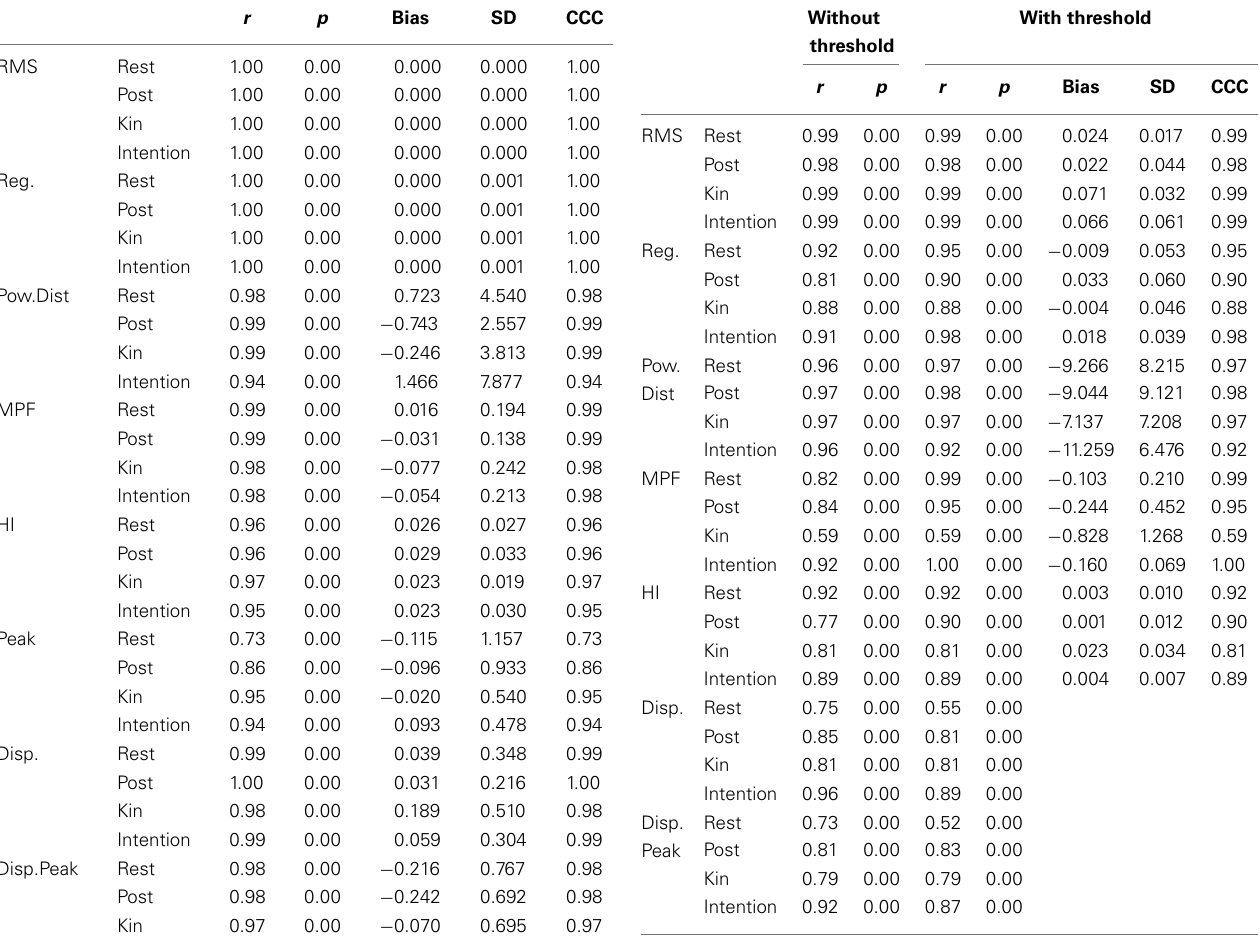
Correlation coefficients are shown for every task performed. Correlation coef- ficients were obtained for every variable calculated by the smart phone. RMS, root mean square (tremor amplitude); Reg., tremor regularity; Pow.Dist, power distribution; MPF, median power frequency; Disp., power dispersion; Disp. Peak, dispersion centered at peak power frequency; HI, harmonic index; SP, results obtained directly from the smart phone;Acc, results obtained by post-processing thetimeseriesfromtheaccelerometer.Correlationswereperformedwithoutany threshold to the results as well as after removing all trials having tremor ampli- tude below 1mm.Then, for variables showing high correlation coefficients (i.e., RMS, Regularity, Pow.Dist, MPF, and HI), bias between both results and standard deviation (SD) of the difference between results of both methods were com- puted. Finally, the concordance correlation coefficient (CCC) was also computed between both